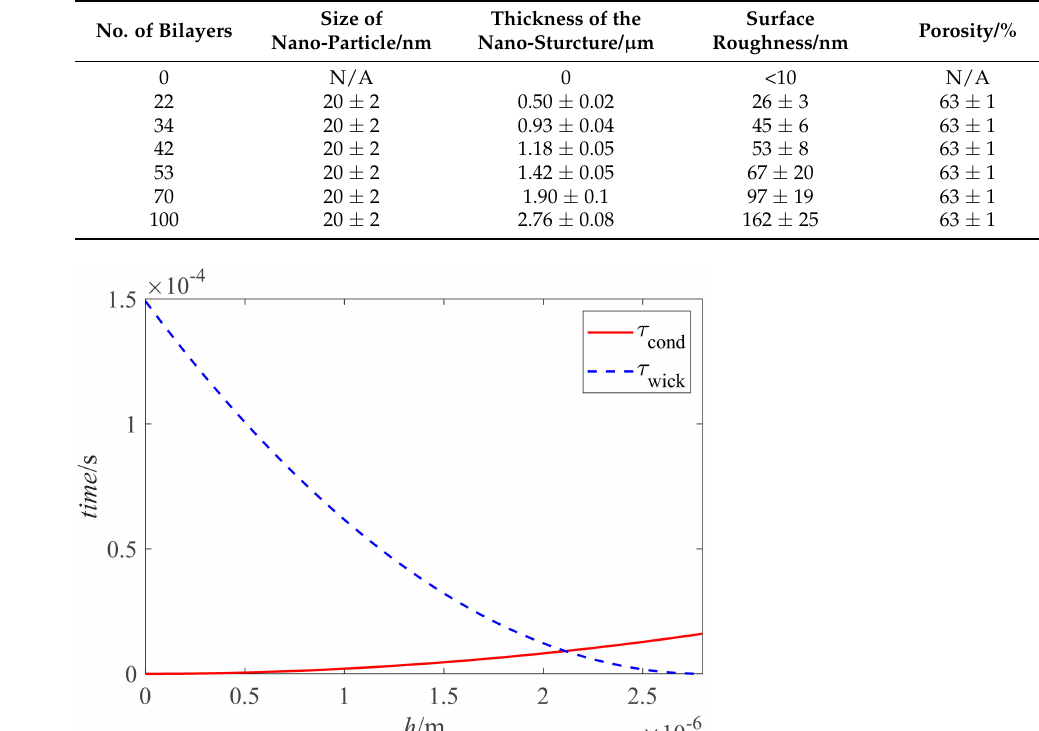
Table 1. Parameters of LbL nano-structured surfaces with different numbers of bilayers.